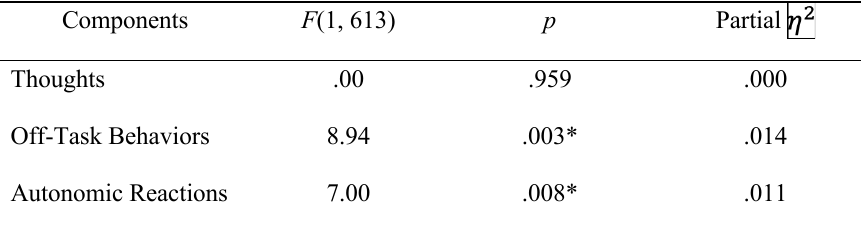
Table 2 Summary statistics for the One-Way